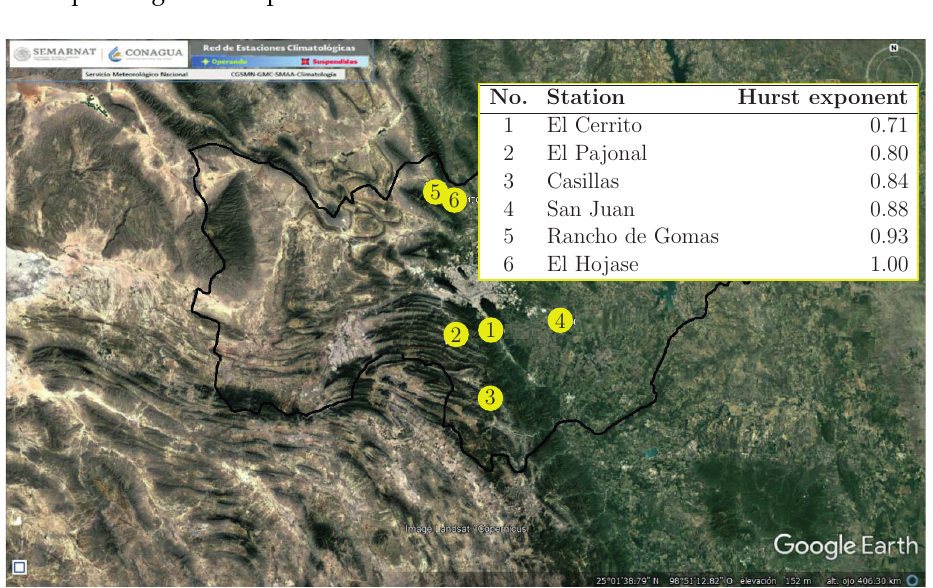
Figure 2. Selected stations and their Hurst